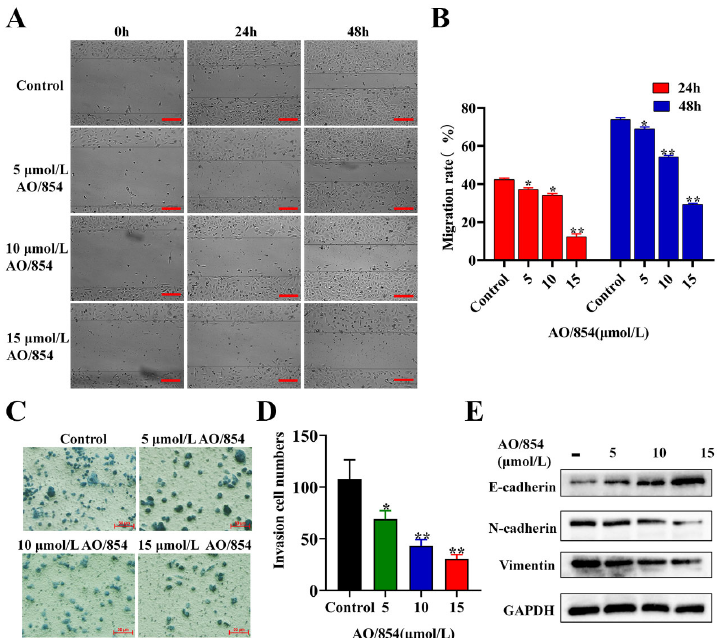
Figure 5. AO/854 repressed cell invasion and migration in PC3 cells. ( A ) Inhibitory effects of AO/854 (5, 10, and 15 μ mol/L) on the migration activity of PC3 cells by scratch wound ‐ healing assay. Scale bars: 50 μ m. ( B ) Quantification of migration experiments in AO/854 (5, 10, and 15 μ mol/L) ‐ treated groups compared with DMSO ‐ treated group (control group). (* p < 0.05, ** p < 0.01). ( C ) Inhibitory effects of AO/854 (5, 10, and 15 μ mol/L) on invasion activity of PC3 cells by transwell assay. Scale bars: 50 μ m. ( D ) Quantification of invasion experiments in AO/854 (5, 10, and 15 μ mol/L) ‐ treated groups compared with DMSO ‐ treated groups (control group). (* p < 0.05, ** p < 0.01). ( E ) Protein